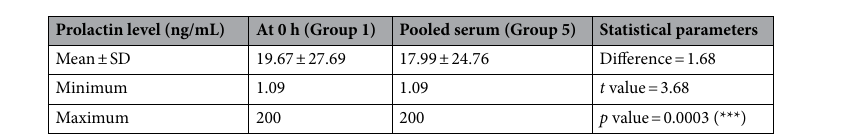
Table 1. Results along with statistical analysis (paired t -test) of serum prolactin level in different groups in Phase 1 study.